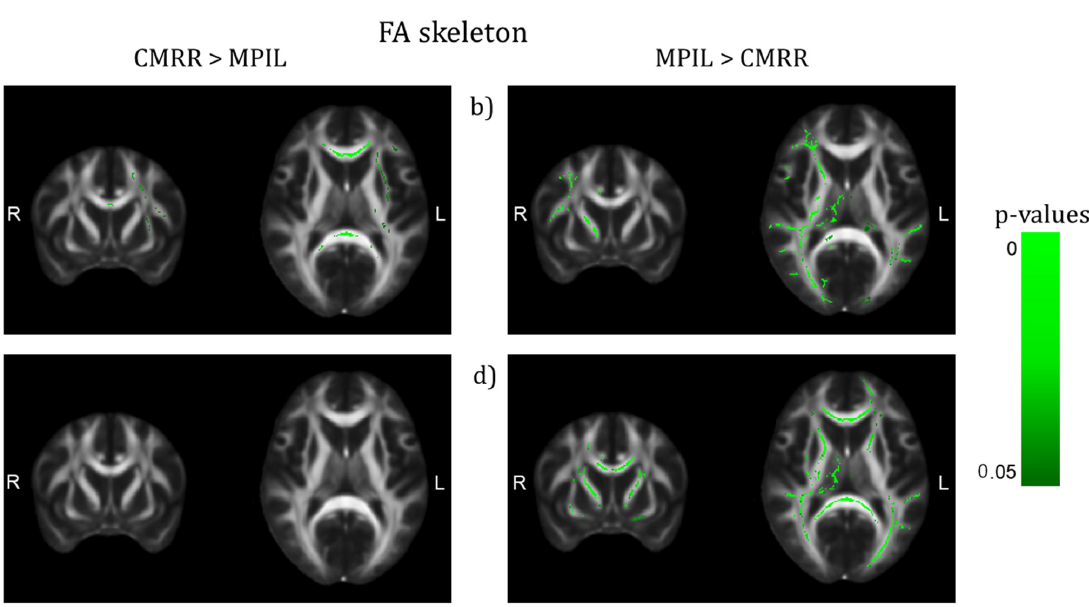
Figure 6. TBSS of differences on the FA skeleton between sequences after preprocessing with denoising (TFCE corrected, highlighted white matter areas: p < 0.05, (y,z) = (9,10)). ( a , b ) Verio: CMRR shows higher FA values in central brain areas, mainly in the CC, whereas MPIL shows higher FA values in lateral areas in the right hemisphere. ( c , d ) Skyra: MPIL delivers higher FA values in both hemispheres.